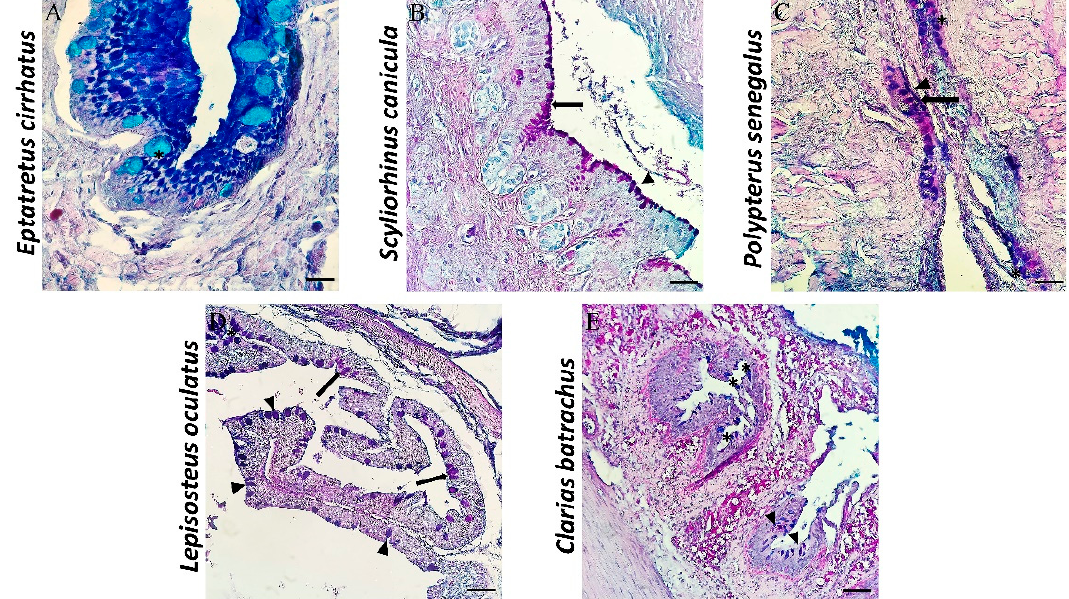
Figure 4. Sections of intestine stained with AB/PAS, 40x, scale bar 40 µm. ( A ) In the intestine of Eptatretus cirrhatus , mucous cells according to the type of secretion (acid in blue, neutral in magenta, and mixed in purple) can be distinguished. Staining highlights several mucous cells with an ovoid shape in blue (*) with acidophilic secretion. ( B ) Two mucous cell populations, neutral mucous (magenta) (arrows) and mixed secretion mucous cells (neutral and acid) (purple) (arrowheads), were detected in the intestine of Scyliorhinus canicula . ( C ) Mucous cells are abundant and can take different forms, namely ovoid, columnar, or pear-shaped, in the intestine of Polypterus senegalus . The presence of all three types of mucins (acidic, neutral, and mixed) is evident. ( D ) In sections of the intestine of Lepisosteus oculatus , the mucous secretion shows the presence of acidic, neutral, and mixed mucins. ( E ) The mucous cells on the apex of the intestinal crests of Clarias batrachus are strongly positive for AB/PAS histochemical staining, demonstrating the presence of acidic, neutral, and mixed mucins. The mucosa of Scyliorhinus canicula is organized in folds with an almost oblique orientation and a conformation comparable to that of the intestinal villi of mammals. The mucous layer is characterized by a columnar epithelium of enterocytes (Figure 3B), with many PAS-positive mucous cells (Figure 4B). Two mucous cell populations, neutral mucous (magenta) and mixed secretion mucous cells (neutral and acid) (purple), were detected with AB/PAS histochemical staining (Figure 4B). Scattered immune cells (l) forming intestinal- associated lymphoid tissue (GALT) in the lamina propria (lp) are